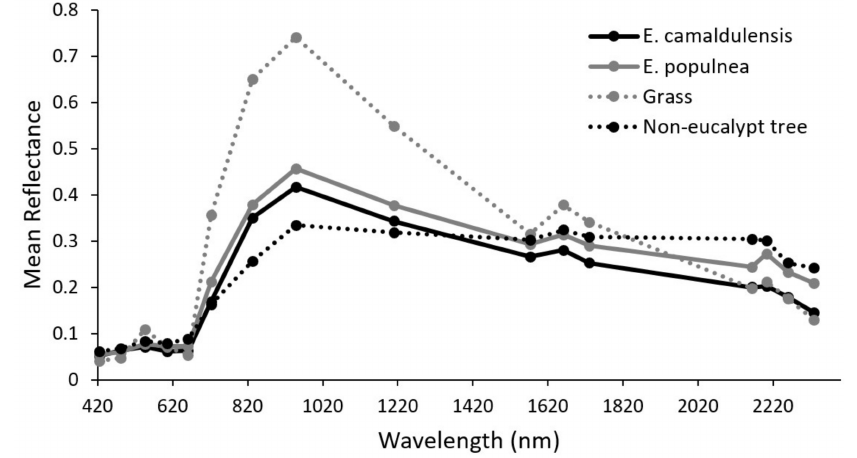
Figure 6. Average reflectance of Eucalyptus camaldulensis and E. populnea (solid lines), non-eucalypt tree and grass (dashed lines) at 16 spectral bands from WorldView-3 images at 7.5 m spatial